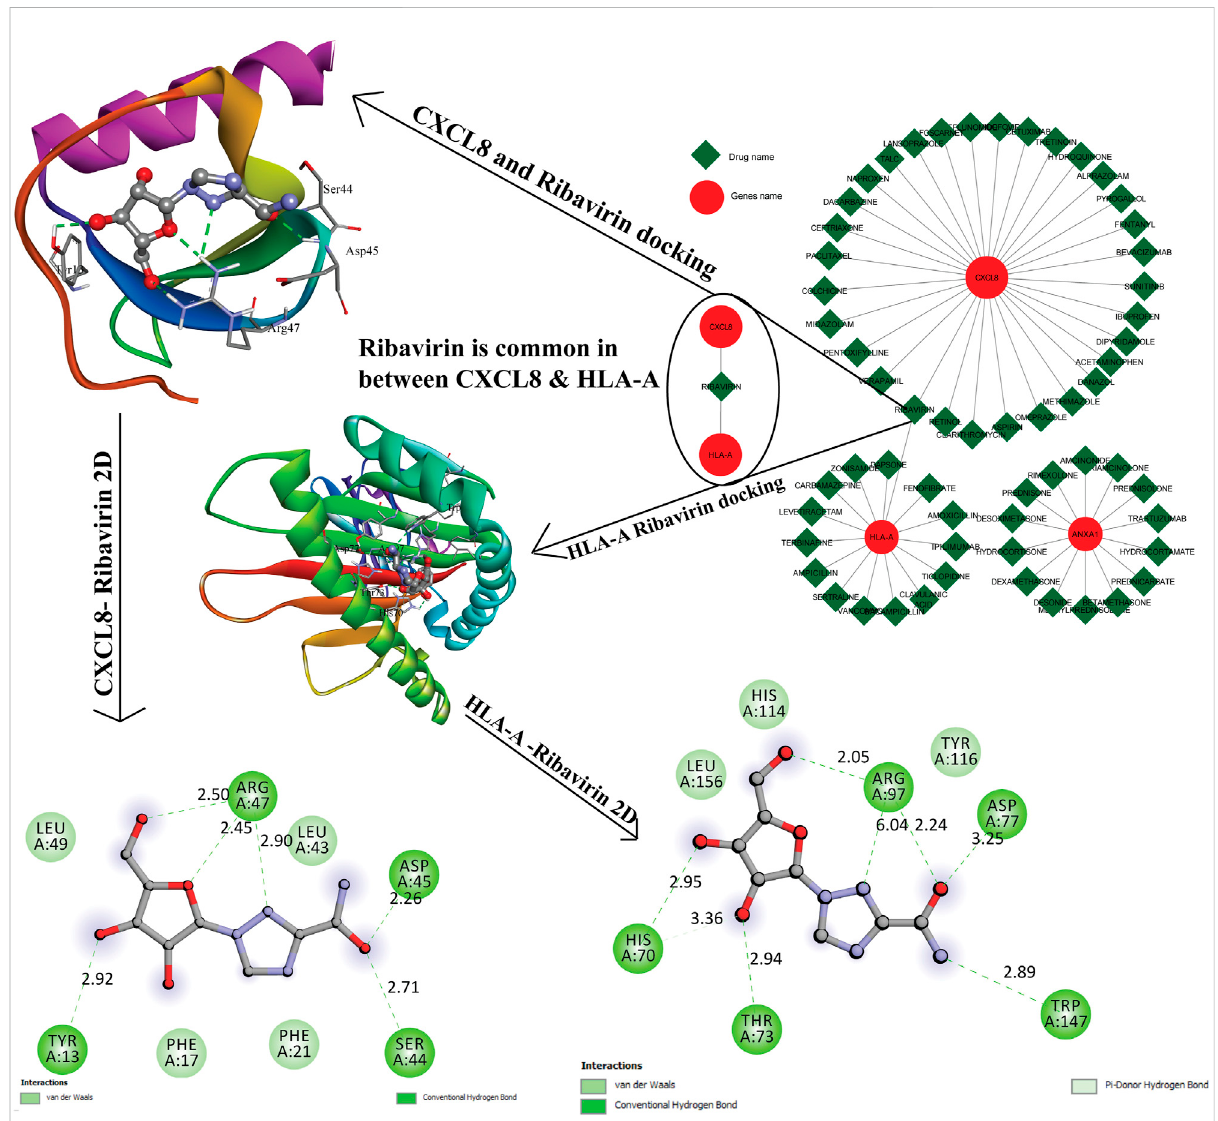
FIGURE 7 The gene-to-drug interaction network was shown in the fi gure, the red color nodes are key genes, and the green color nodes their targets drugs. Out of six genes, three genes were making interaction with their target drugs. Ribavirin was a common drug for two genes. This fi gure shows the 3D interaction and the 2D interaction with ribavirin and CXCL8, HLA-A